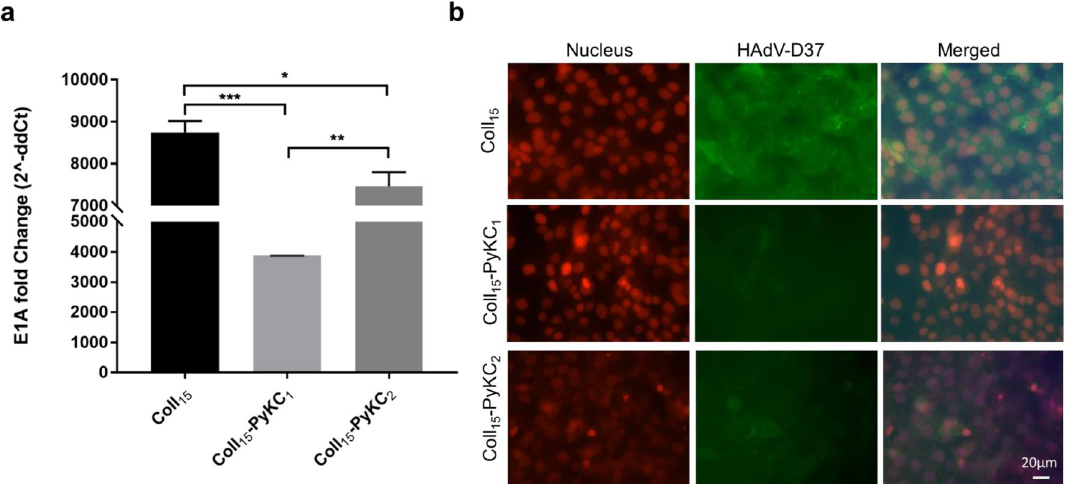
Figure 7. ( a ) Fold changes of the viral E1A gene were evaluated at 24 h post infection hours using real-time PCR. The amount of E1A was significantly less with Coll 15- PyKC 1 compared to Coll 15. Data was normalized to GAPDH and are expressed as the mean ± standard deviation. The quantification of E1A was calculated using the 2^-ddCt method, and the results are presented as relative fold change. A value of p < 0.05 was considered statistically significant. *, **, and *** represent p < 0.05, p < 0.01, and p < 0.001, respectively. ( b ) Immunofluorescence assay. Immunostaining for HAdV-D37 in human corneal epithelial cells (HCECs) cultured on different infected hydrogels. Cells were observed at 48 hpi, green fluorescence indicates the adenovirus load as assessed with anti-Ad5 and secondary antibody conjugated with FITC and red represents nuclei stained with EthD-1. The scale bar is 20